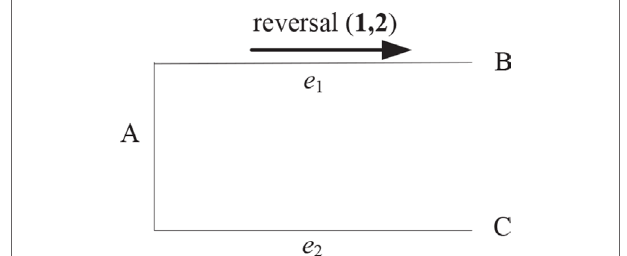
FIGURE 2 | The tree topology with two taxa ( B and C